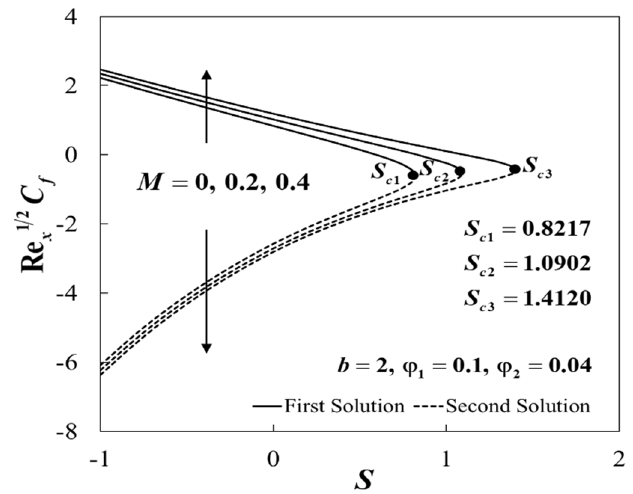
Figure 8. Impact of M and S on Re 1/2 x C f .